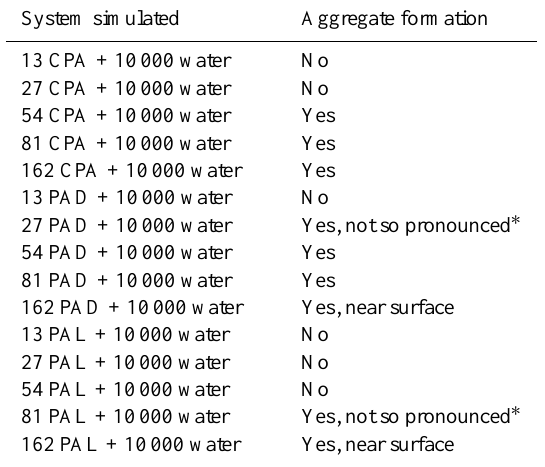
Table 1. Aggregation formation in the simulations of nanoaerosol